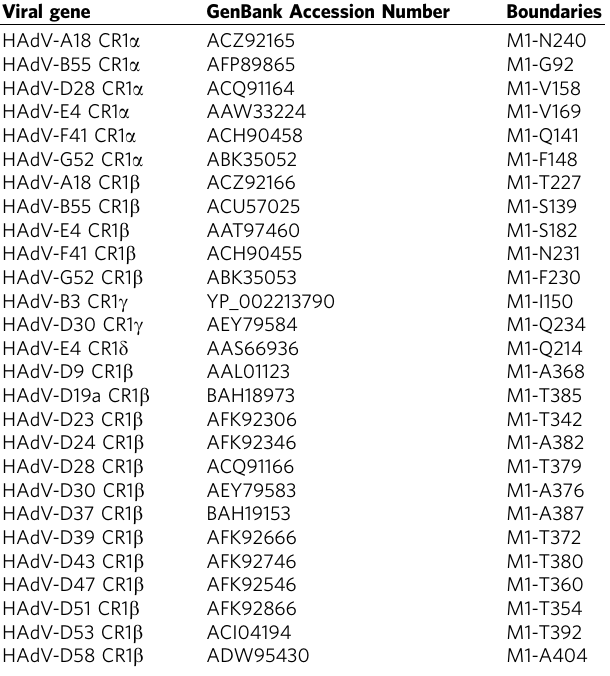
Table 1 | GenBank accession numbers and amino-acid boundaries utilized for cloning of each of the viral proteins in this